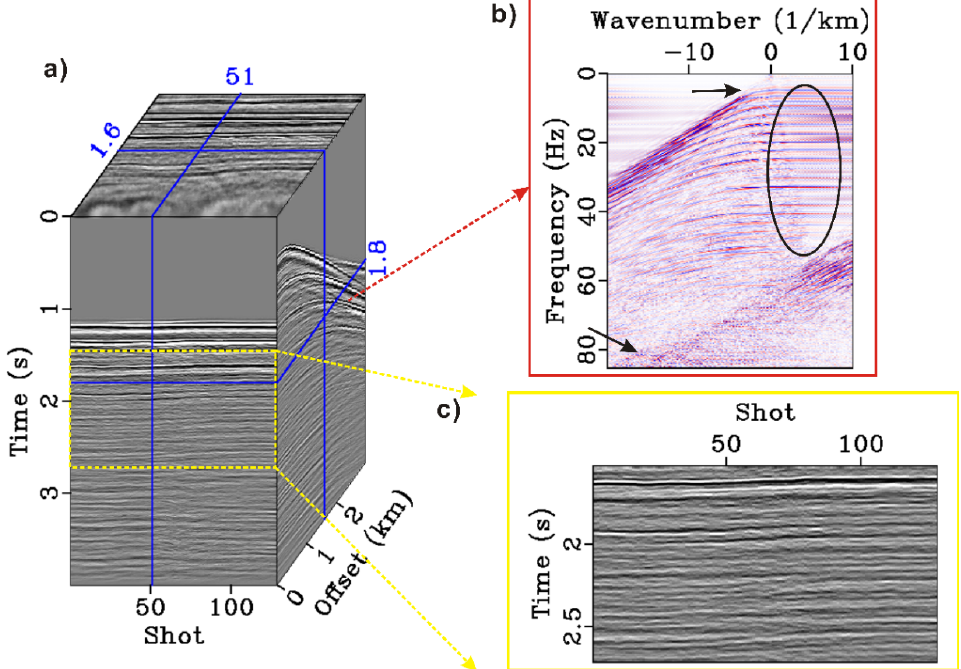
Figure 12. The sparse inversion-based deghosting results. ( a ) 3D data cube including 193 CSGs and 128 COGs. ( b ) f - k spectrum in which the black oval marks the effect of ghost. ( c ) COG wherein the events are similar to the underground interface.